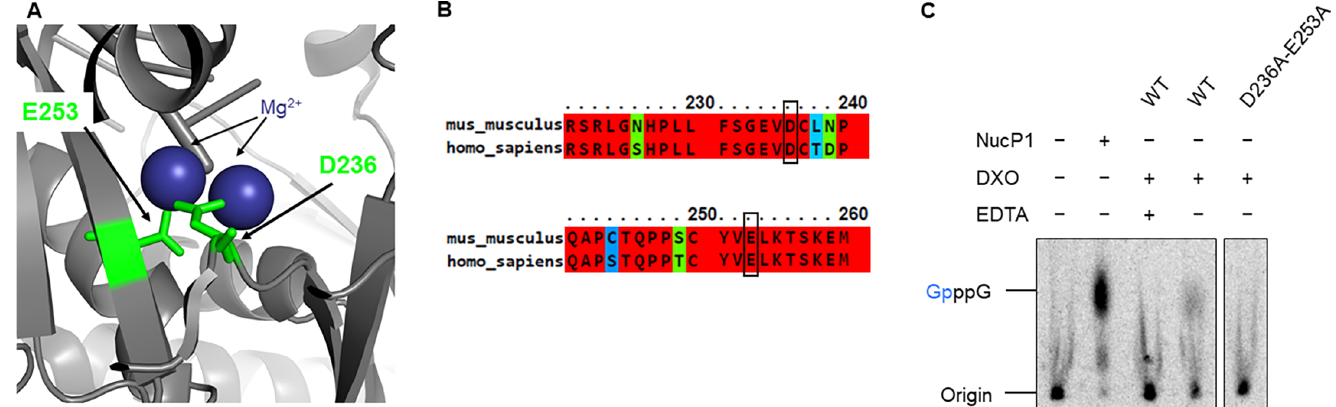
Fig 2. Catalytically inactive DXO. (A) Two residues involved in the coordination of Mg 2+ ions in the active site of mouse DXO (pdb 4j7l) are shown. (B) Sequence conservation of residues coordinating Mg 2+ ions between mouse and human DXO. (C) To ensure that the observed activity is indeed due to DXO, the catalytically inactive D236A/E253A mutant was used in a decapping assay using GpppG-RNA as substrate. Wild-type DXO readily hydrolyzes this cap structure in the presence of magnesium. However, no hydrolysis is observed with the catalytically inactive DXO mutant.